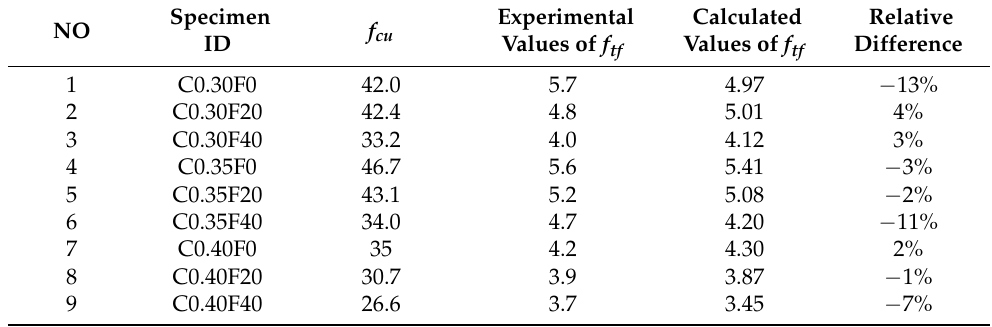
Table 10. Relative difference of calculated value and experimental value of flexural